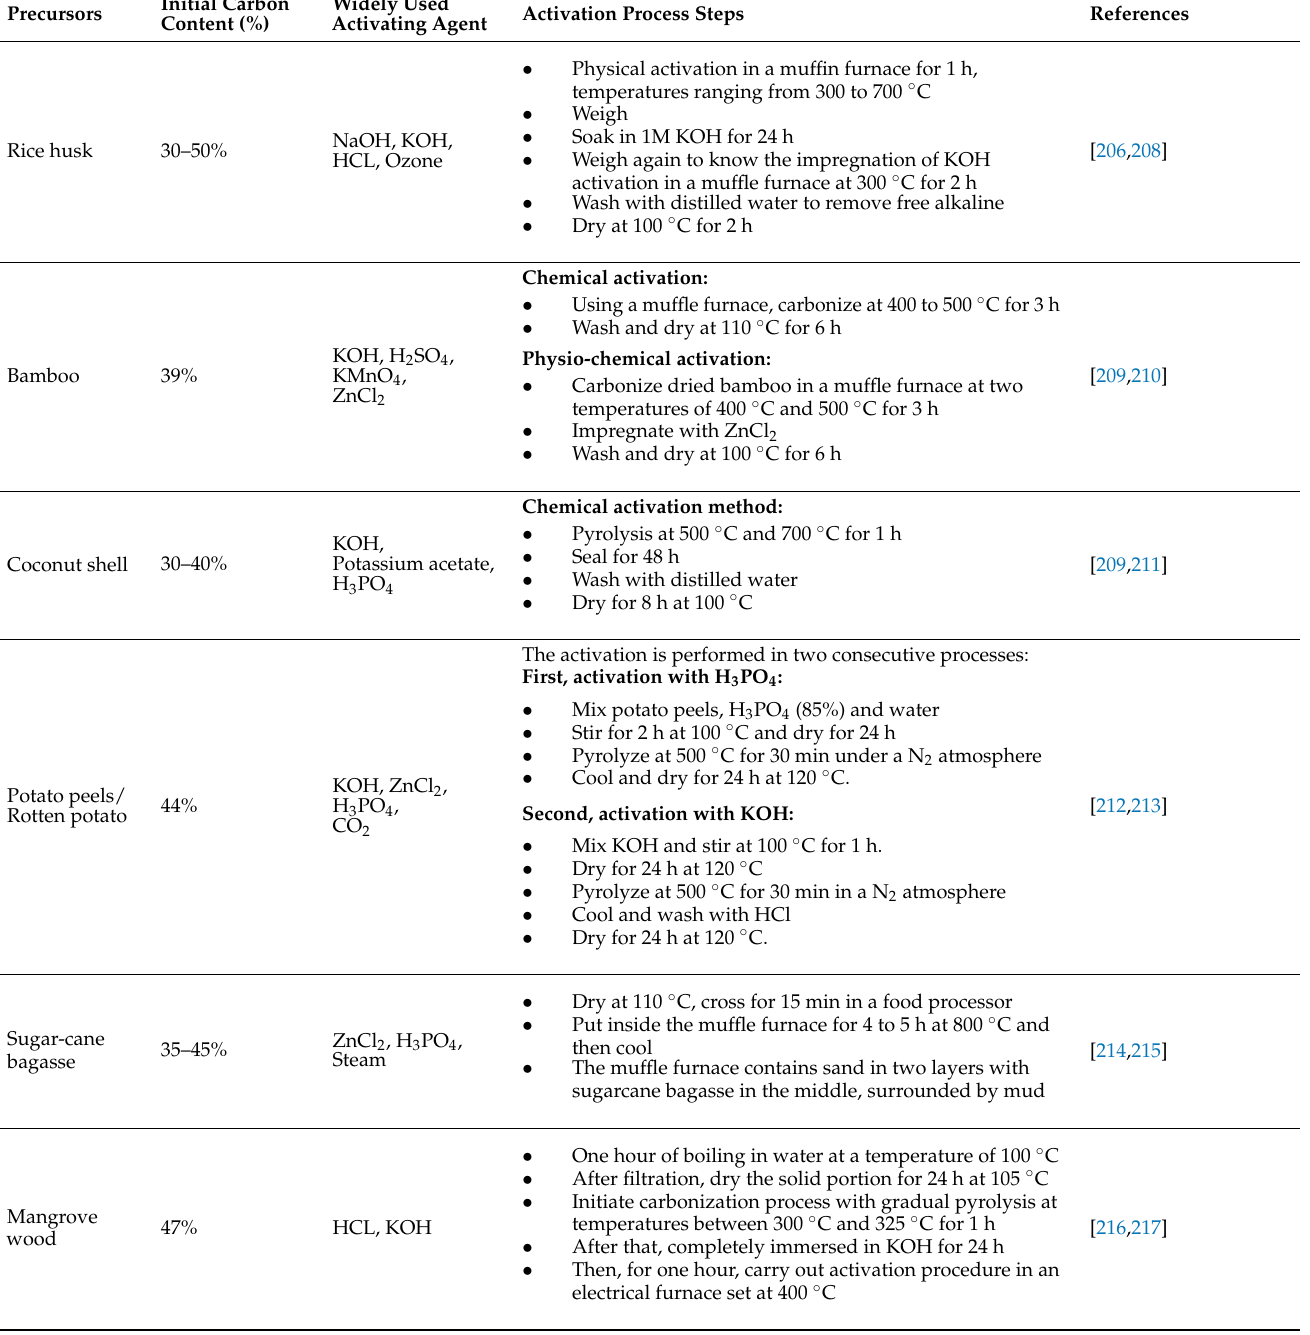
Table 6. Summary of activation conditions for the production of AC from different biomass